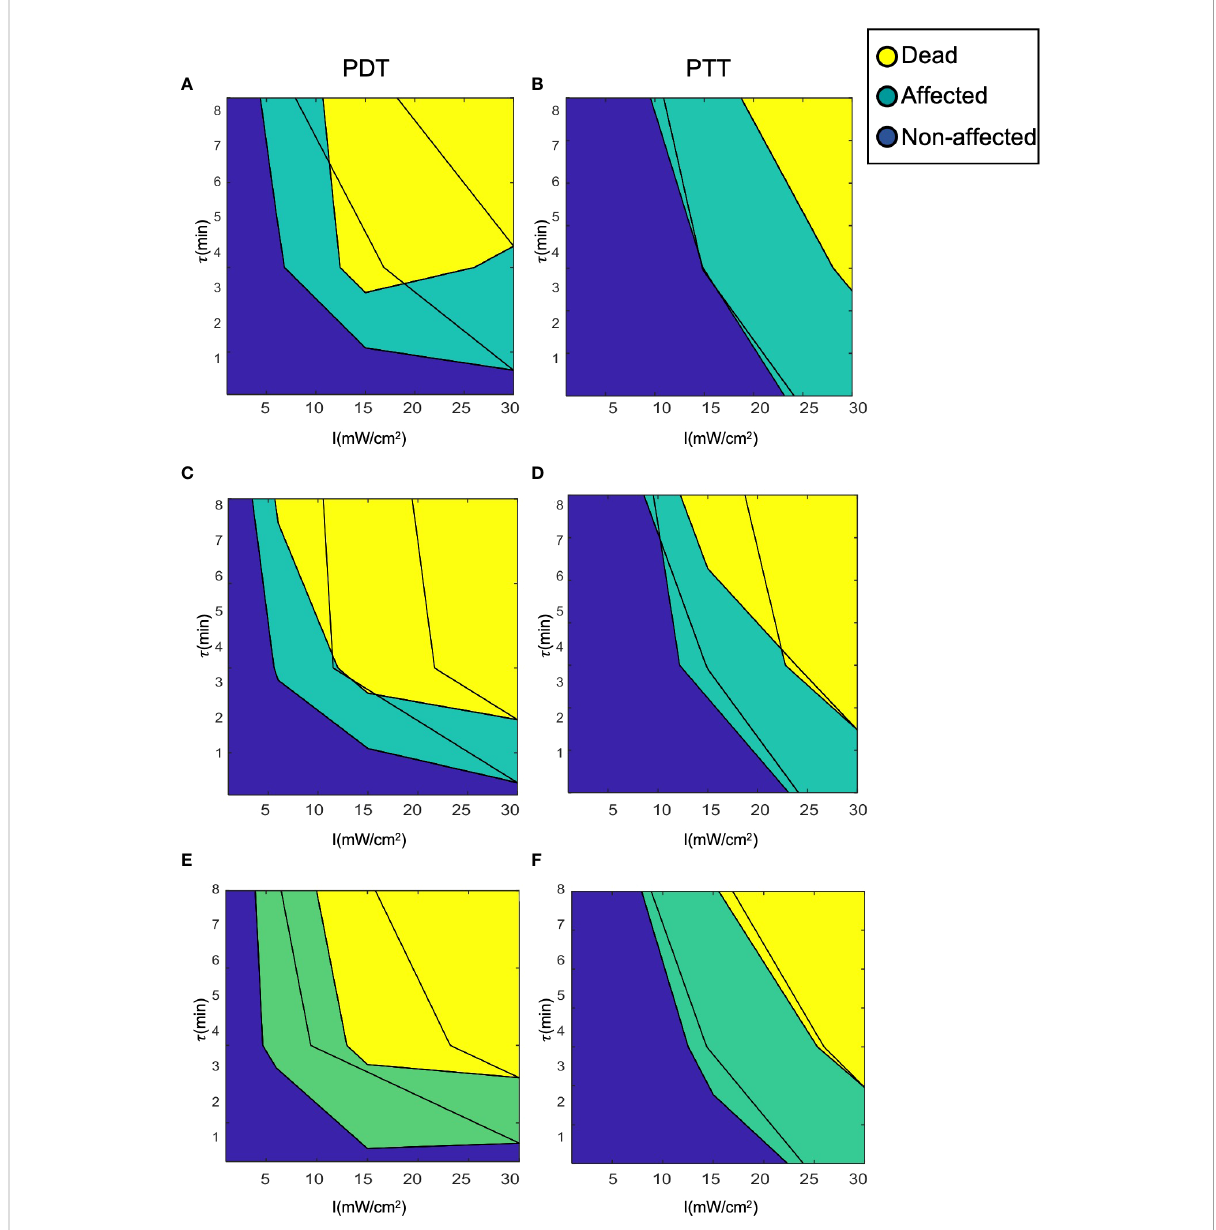
FIGURE 9 Clustering of cells into the three clinical classes (dead, affected, and unaffected). (A, B) LOWESS regression, (C, D) interpolation, (E, F) analytical